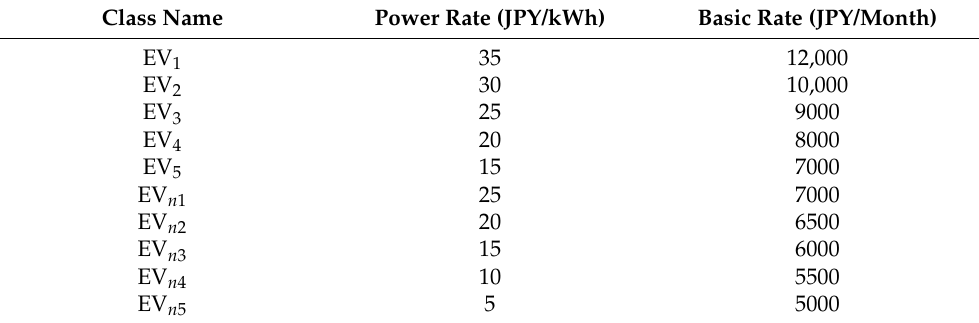
Table 2. EV contract class.